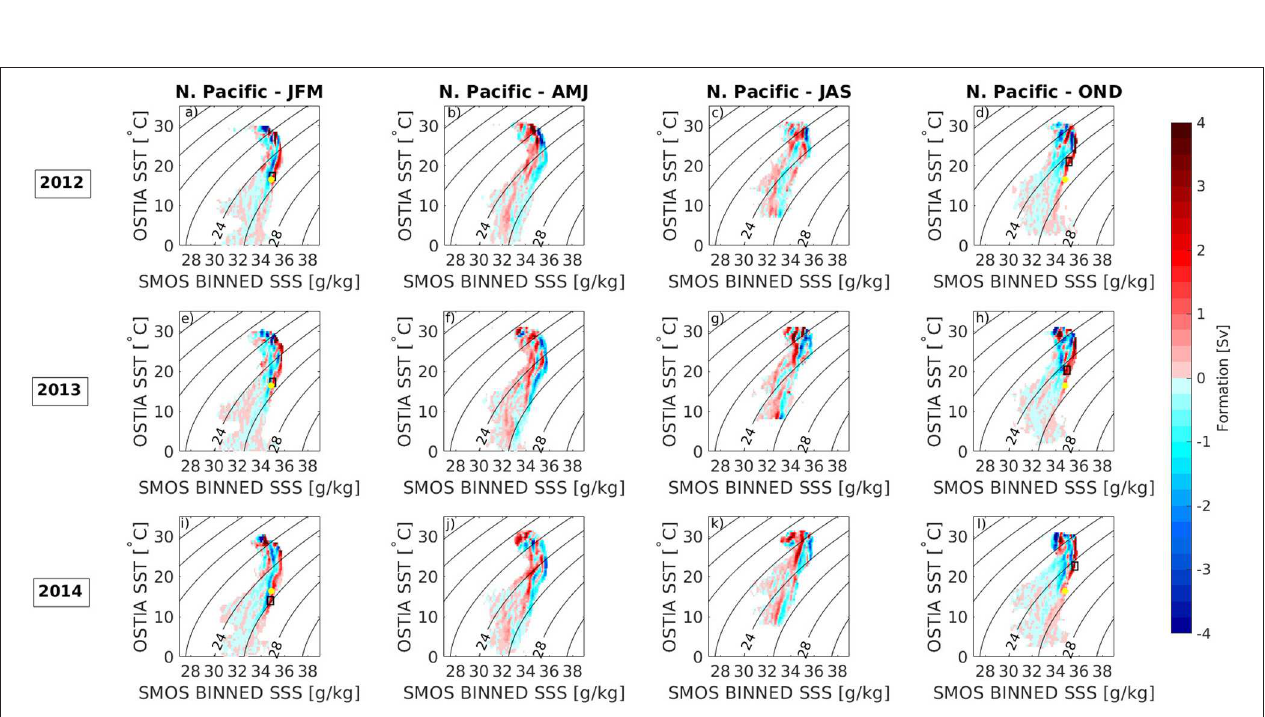
FIGURE 7 | Same as Figure 6 but for the North Pacific and the yellow dots in the left and right most columns (JFM and OND) show the literature properties of the North Pacific STMW (Hanawa and Hoshino, 1988; Yasuda and Hanawa, 1997; Hanawa and Yoritaka, 2001).